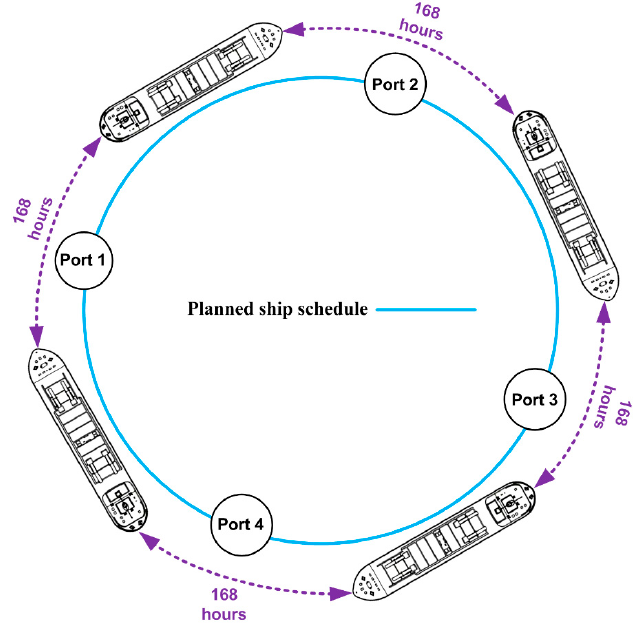
Figure 5. Maintaining the agreed frequency of port service.